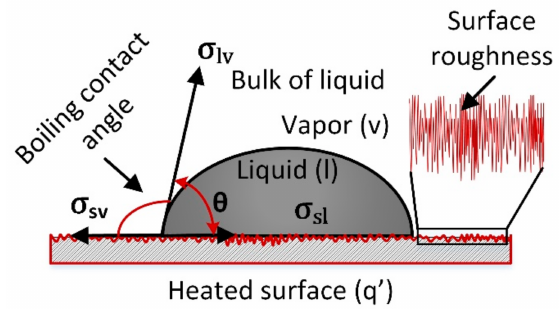
Figure 8. Nucleate boiling contact angle according to